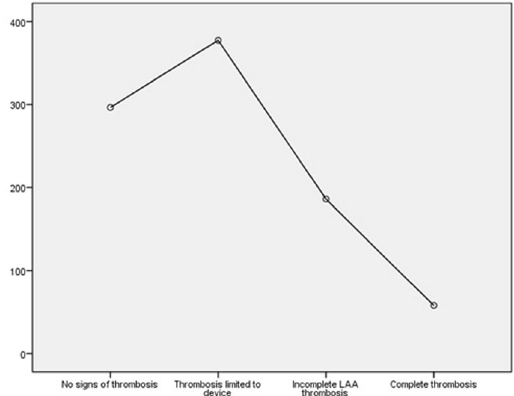
Figure 2. Mean density (HU) in different levels of thrombosis (y-axis). Mean density was: no signs of thrombosis: 296.43 (STD 197,8); device limited thrombosis: 377.30 (STD 112.3); incomplete LAA thrombosis: 185,98 (STD 161.61); complete thrombosis: 57.94 (STD 37.33). Post-hoc test (Games-Howell) revealed a significant difference between device limited thrombosis compared to incomplete LAA thrombosis (191.33, 95%-CI [6.18 –, 376.47]; p = 0.042) and complete thrombosis (319.36; 95%-CI [173.00 –, 465.72]; p =